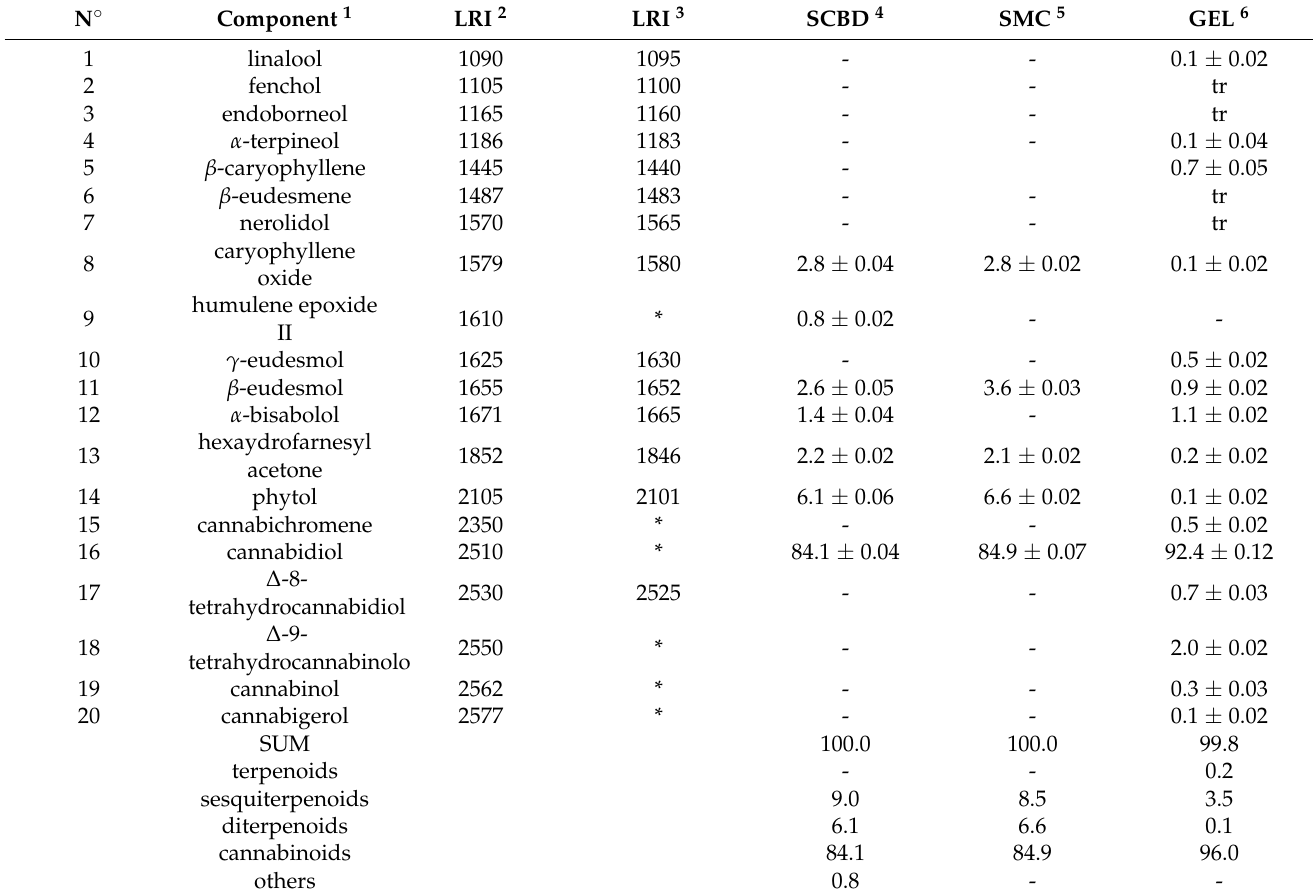
Table 2. Chemical composition (percentage mean value ± standard deviation) of Cannabis sativa L. pollen